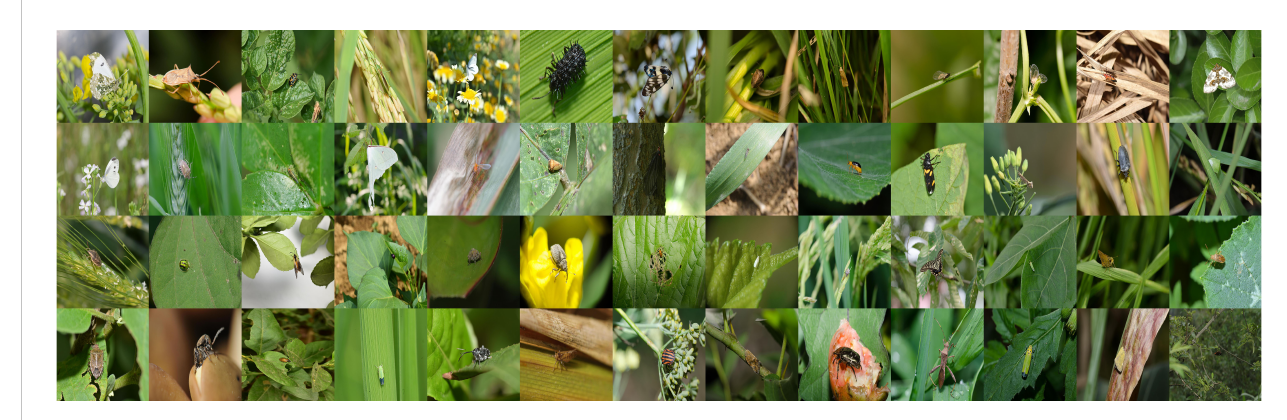
FIGURE 1 Representative demonstration images of each category in the FSIP52 data